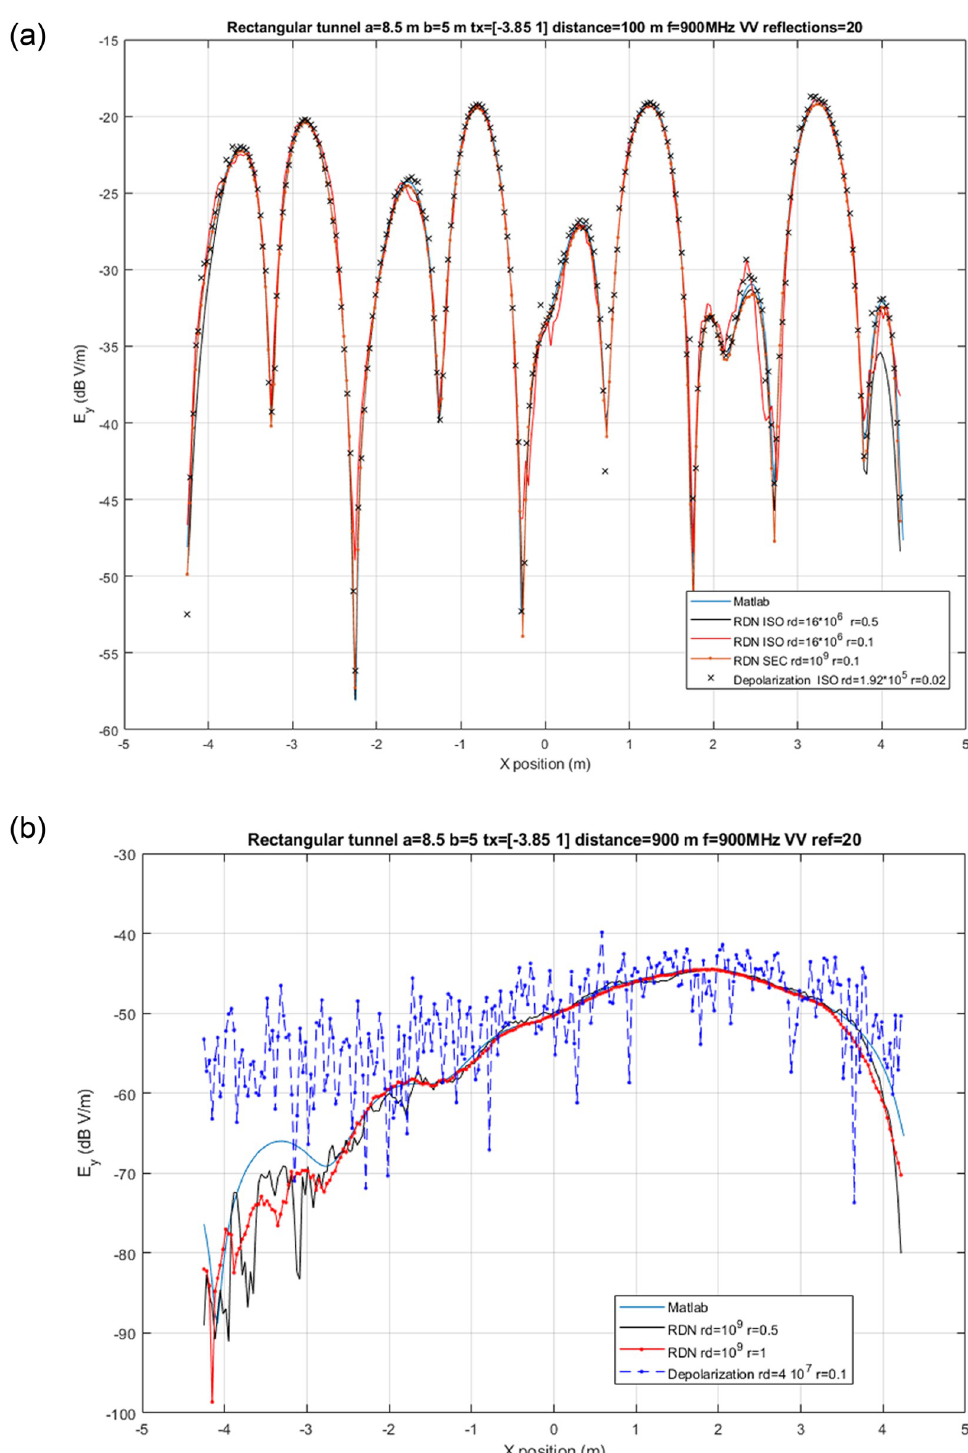
Fig 7. Rectangular tunnel. Simulation of received electric field at cross sections at z = 100 m and z = 900 m of a rectangular tunnel with dimensions 8.5m x 5m x 1000m, EM properties � = 5 and σ = 0.01 S/m. The origin of coordinates r is at the center of the rectangle and beginning of tunnel. Transmitter is placed at [-3.85,1,0] and both transmitter and receivers use vertical polarization with frequency 900 MHz. Maximum number of reflections is 20. Results show electric field computed with RDN and LPR simulations with different reception sphere radius (r) and either half isotropic (ISO) or sectorized (SEC) ray generation with different ray densities (rd). (a) Electric field for cross section at z = 100 m. (b) Electric field for cross section at z = 900